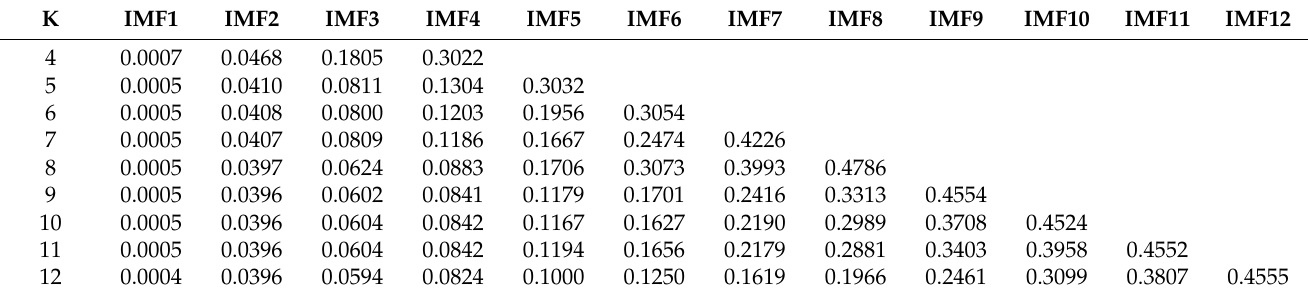
Table 2. Central frequency for the IMF components of the 86 km zonal wind.